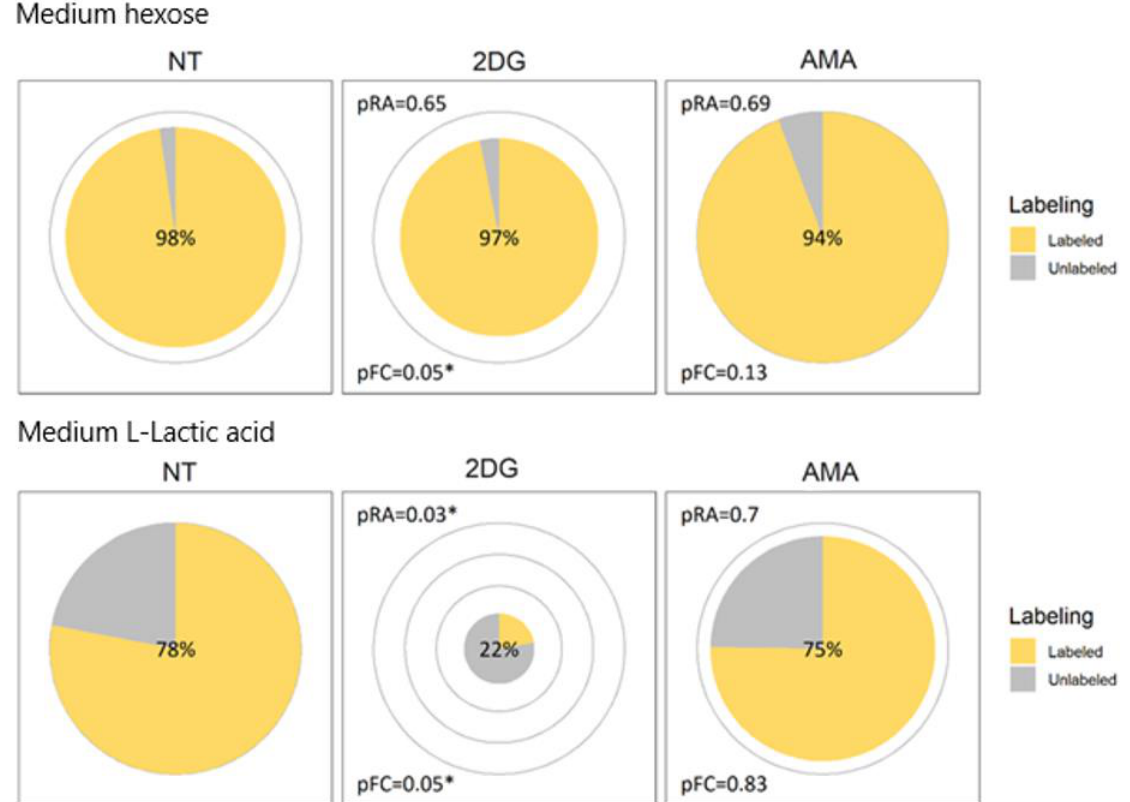
Figure 3. Proposed pie chart visualization for medium hexose and lactic acid applied to three cohorts: non-treated (NT); 25 mM 2-deoxyglucose treated (2DG); or 10 µ M antimycin A treated (AMA). For each metabolite, the pie radii correspond to the relative abundance which can be compared between cohorts of this metabolite. Both the labeled surface fraction of the pie (yellow) and the percentage displayed in the middle of each pie reflect the fractional contribution. pRA and pFC indicate the significance of the difference in, respectively, the relative abundance or fractional contribution with the NT cohort. * indicates a p value ≤ 0.05.